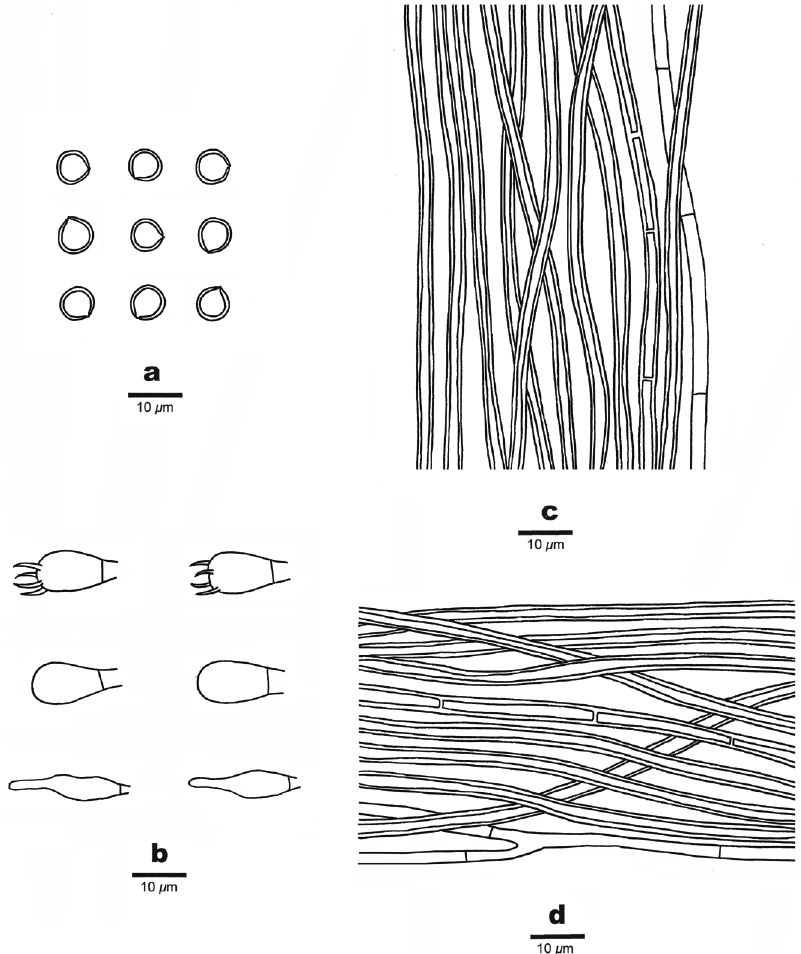
Figure 3. Microscopic structures of Fomitiporia rhamnoides (from the holotype). a Basidiospores b Ba- sidia, basidioles and cystidioles c Hyphae from trama d Hyphae from context.